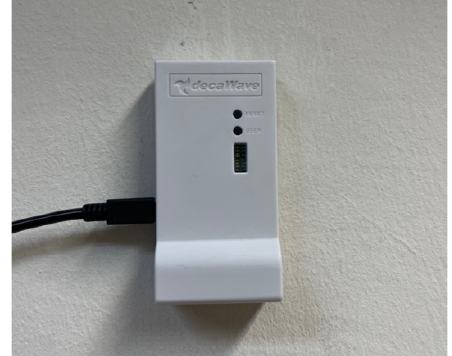
Figure 1: Decawave’s UWB Anchor